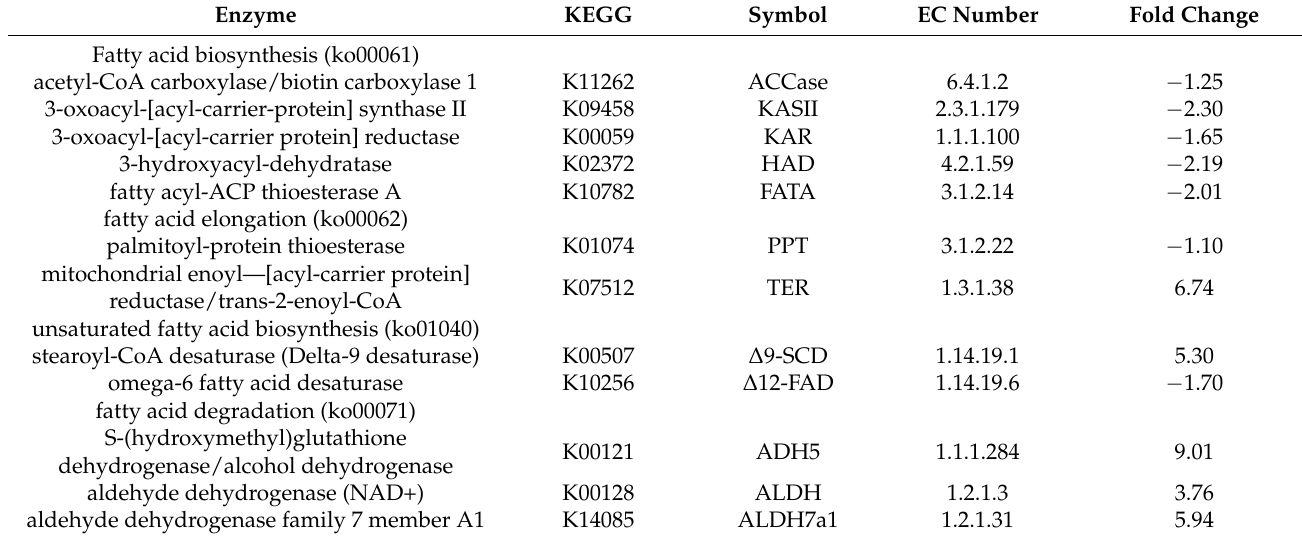
Table 3. Differential expressed genes involved in fatty acid metabolism pathway under salt-free conditions. Enzyme KEGG Symbol EC Number Fold